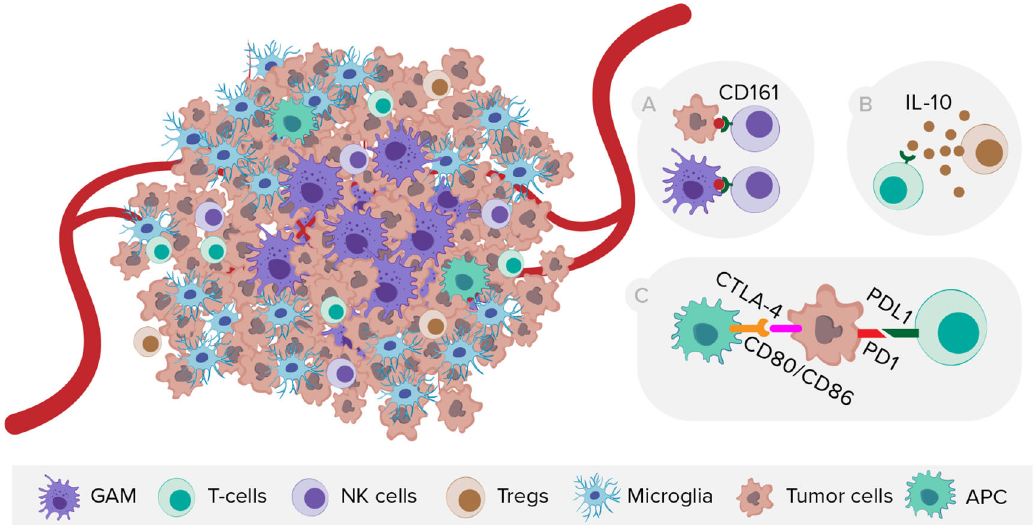
Figure 4. The schematic representation of GBM heterogeneity at the cellular level and selected mechanisms of immunosuppression within TME. NK cells, natural killer cells, Tregs, T regulatory cells, APC, antigen presenting cells. A) Expression of CD161 receptor by NK cells and its ligand CLEC2D by malignant and myeloid cells. B) T-cell exhaustion mediated by TME cells releasing interleukin-10. C) Expression of immune checkpoints on tumor and peritumoral myeloid